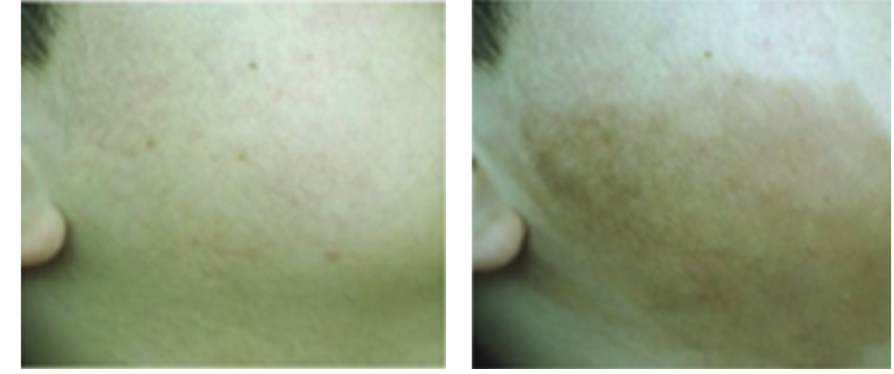
Figure 14: Selected area corresponding to the bigger color difference.